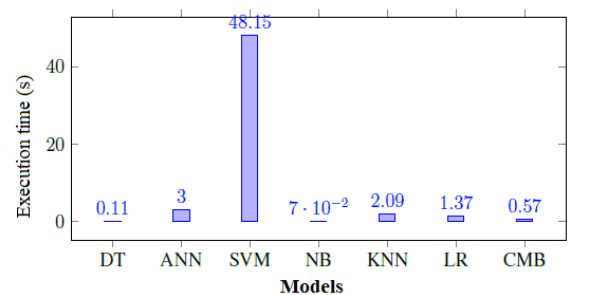
Figure 7. Comparison of model complexity in terms of average minimum processing